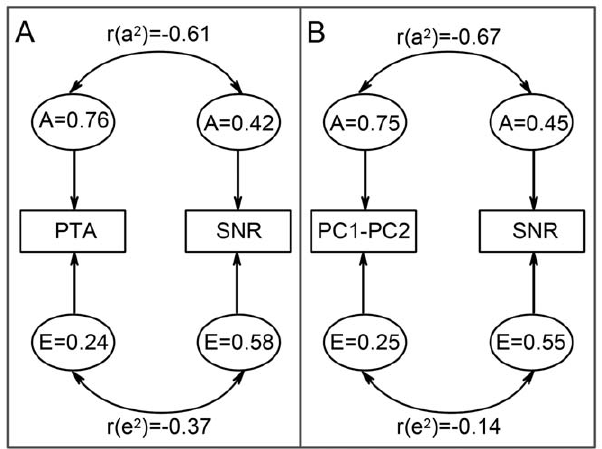
Figure 3. Results of bivariate variance component modelling. Graphical presentation of bivariate variance modelling results for PC1– PC2 &SNR (Panel A) and PTA & SNR (Panel B). Univariate heritability (A) and unique environmental factor (E) estimates are given separately for each trait. Correlation between these factors are given by r(a 2 ) and r(e 2 ), respectively.